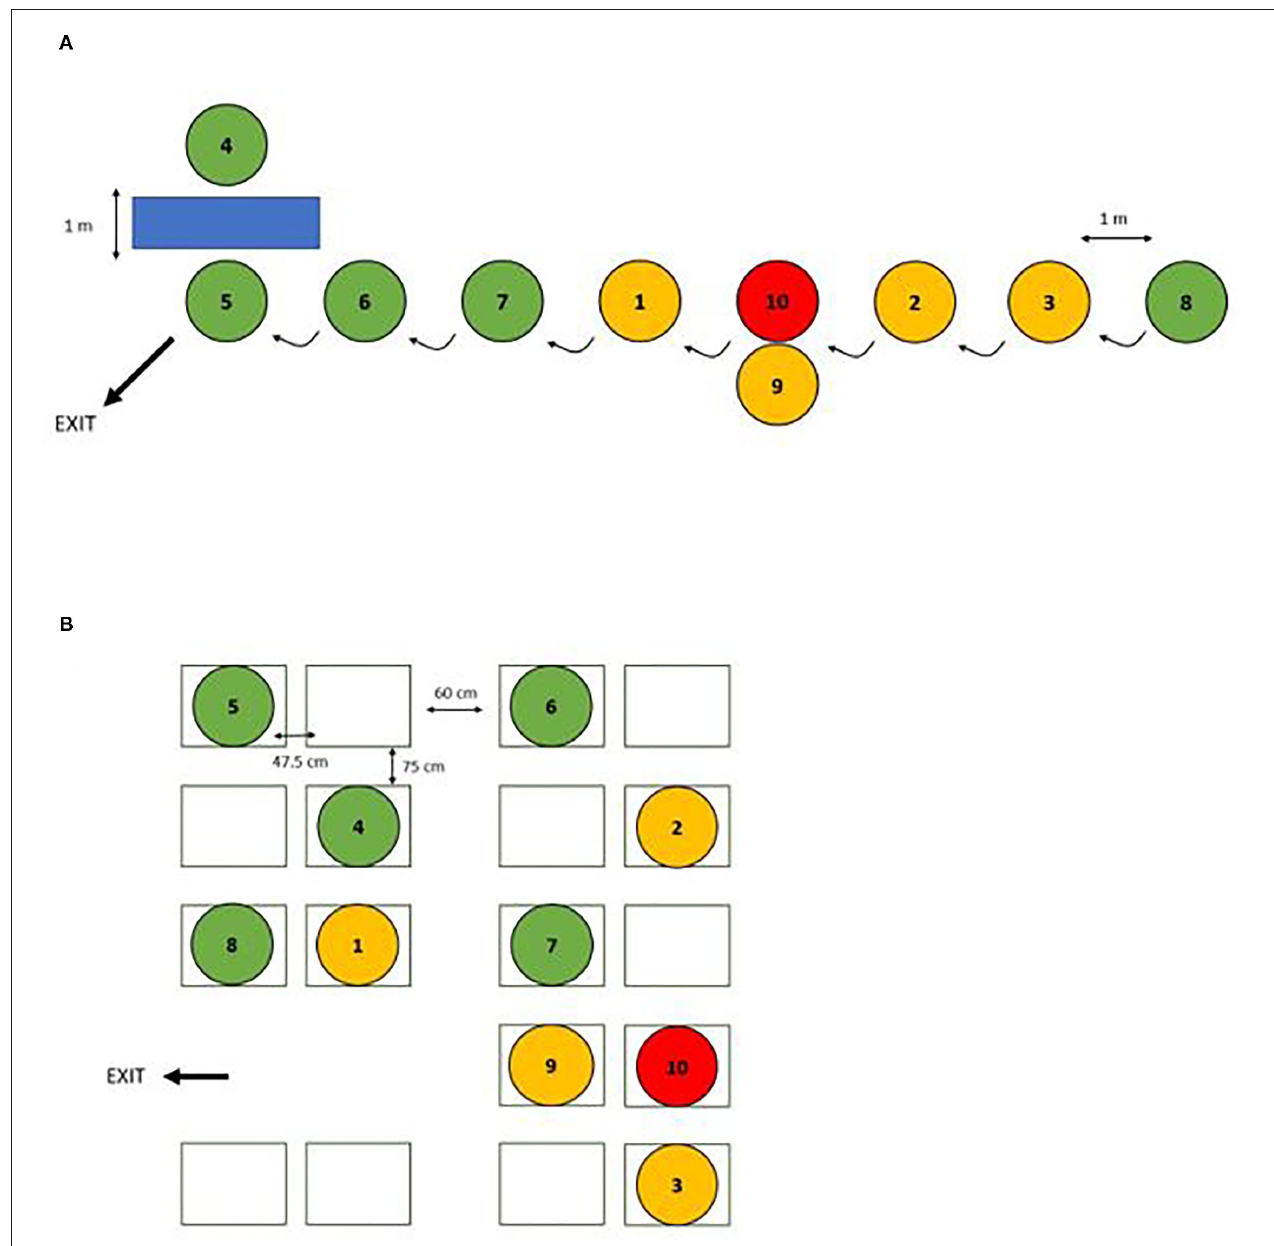
FIGURE 1 | Schematic representation of the (A) “queue” scenario, where participants simulated standing in a queue, and (B) “bus” scenario, where participants simulated taking a bus to evaluate the notification rates via contact tracing under various configuration settings. Red: “infected"; orange: “close contact"; green: “sporadic